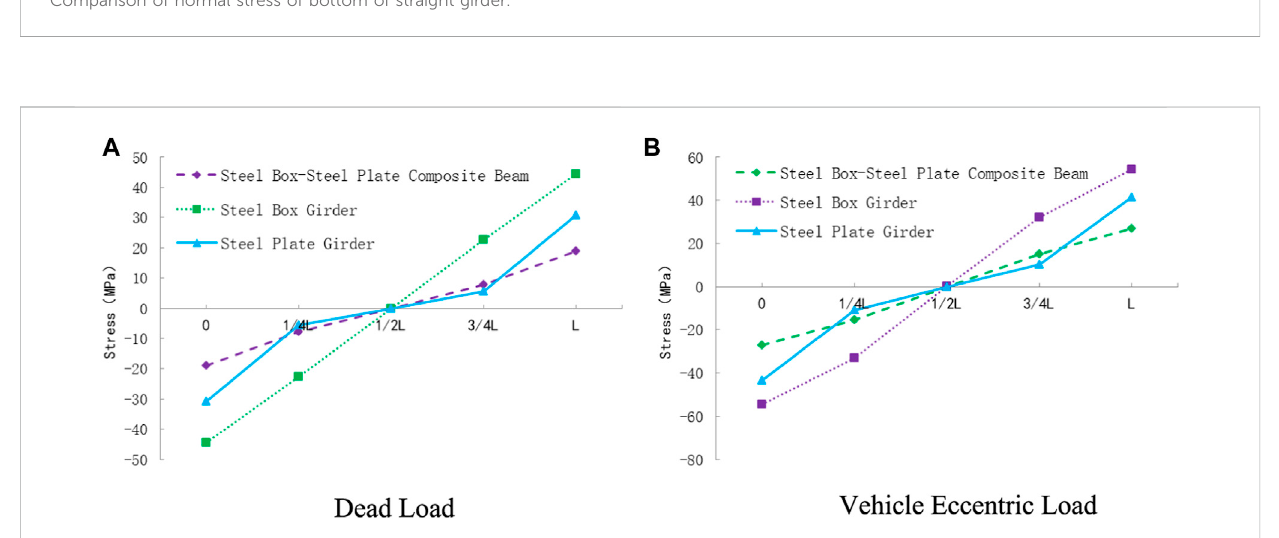
Comparison of web shear stress of straight